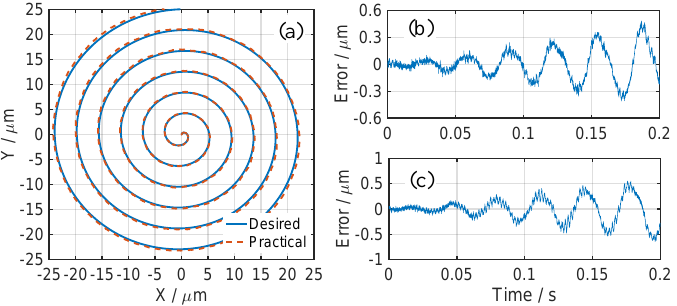
Figure 14. Trajectory tracking performance: ( a ) spiral trajectory tracking, and the error along ( b ) the x -axis and ( c ) the y